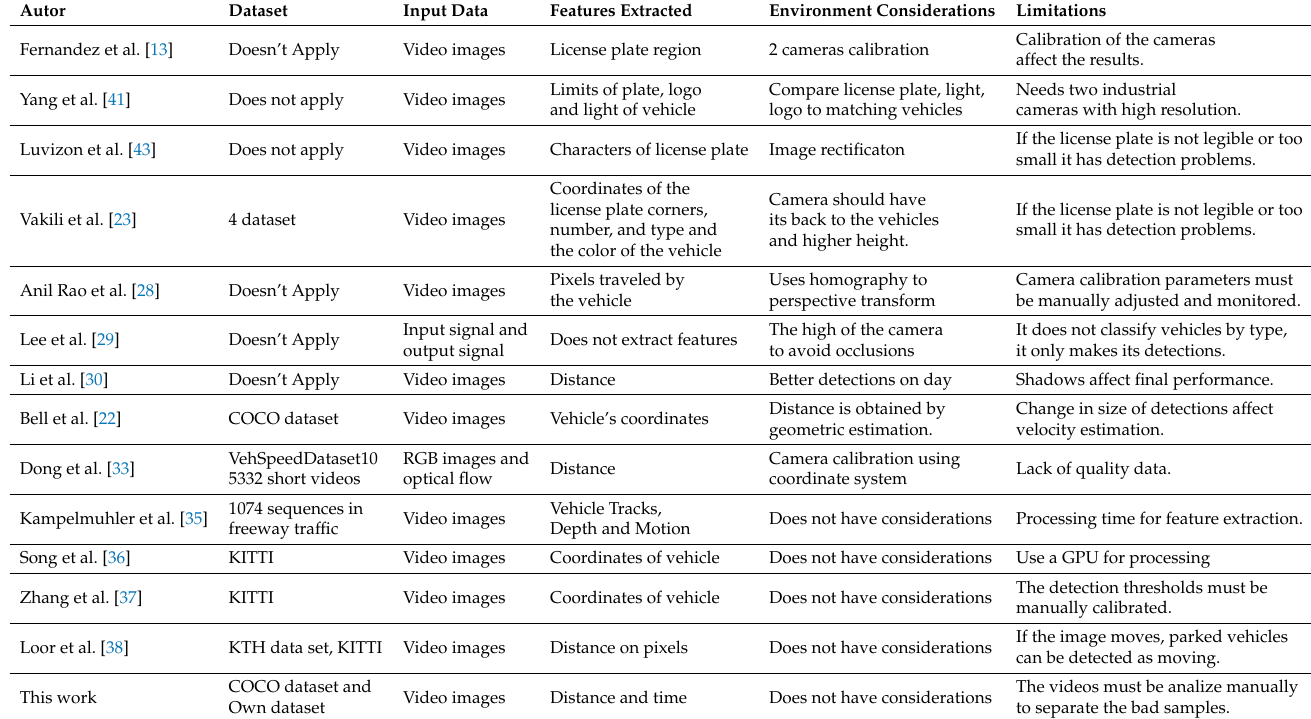
Table 6. Comparison of Input data and Considerations between state-of-the-art works and our proposal.